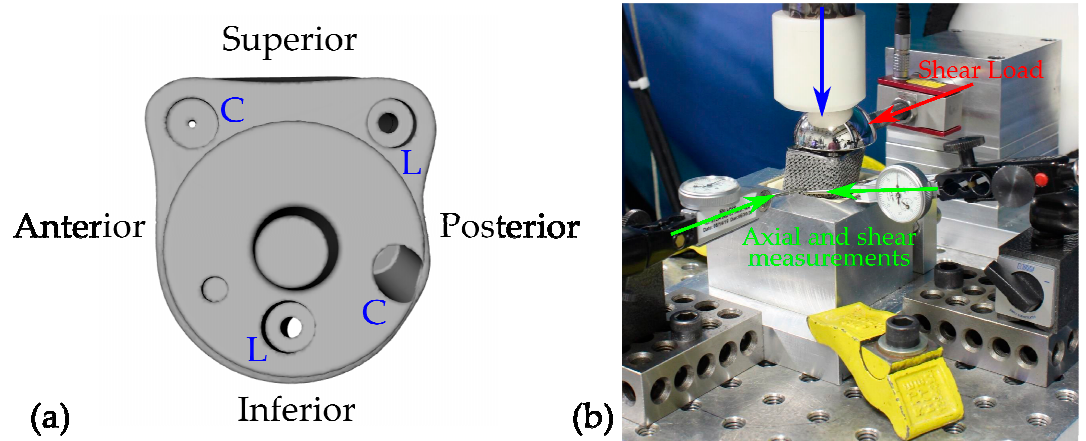
Figure 1. Left ( a ), top view of the custom implant with the four main directions: anterior, posterior, superior and inferior. Four screws were used to fix the implant: two locking (L) and two nonlocking (compression, C). Right ( b ), experimental set-up with a shear load (red arrow) applied inferiorly via a horizontal loading fixture. Axial load was applied through the glenosphere (blue arrow). Axial and shear components of the baseplate displacement were measured superiorly with two dial indicators (green arrows).